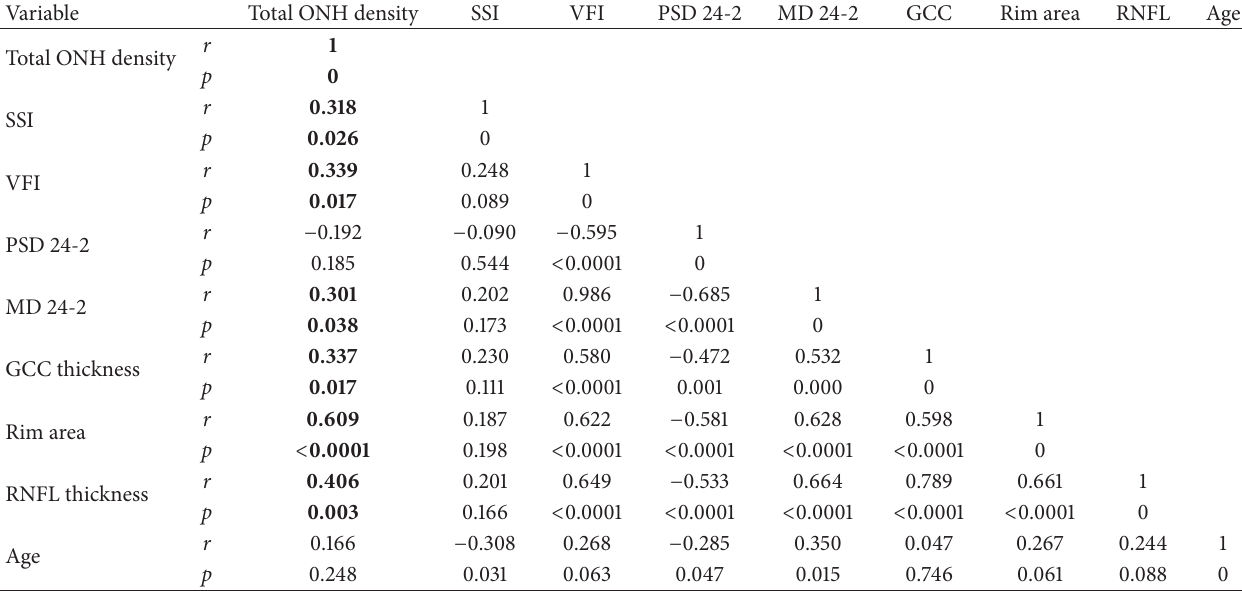
Table 4: Pearson correlation coefficient matrix for visual field, structural variables, and ONH total vessel density in subjects with glaucoma. MD: mean deviation; PSD: pattern standard deviation; VFI: visual field index; RNFL: retinal nerve fiber layers; GCC: ganglion cell complex; total ONH density: total ONH vessel density; SSI: strength signal index. Statistically significant correlations with total ONH vessel density are in bold.